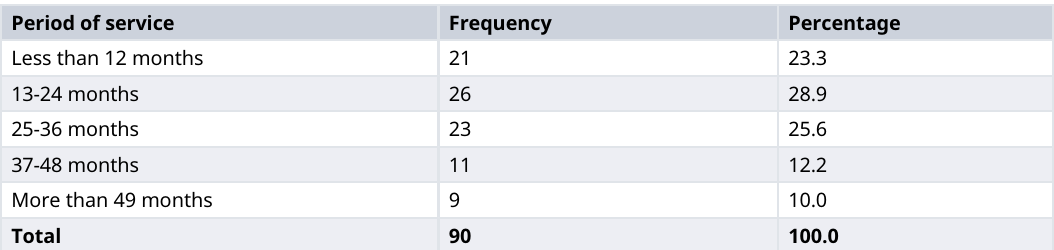
Table 3. Period of service of